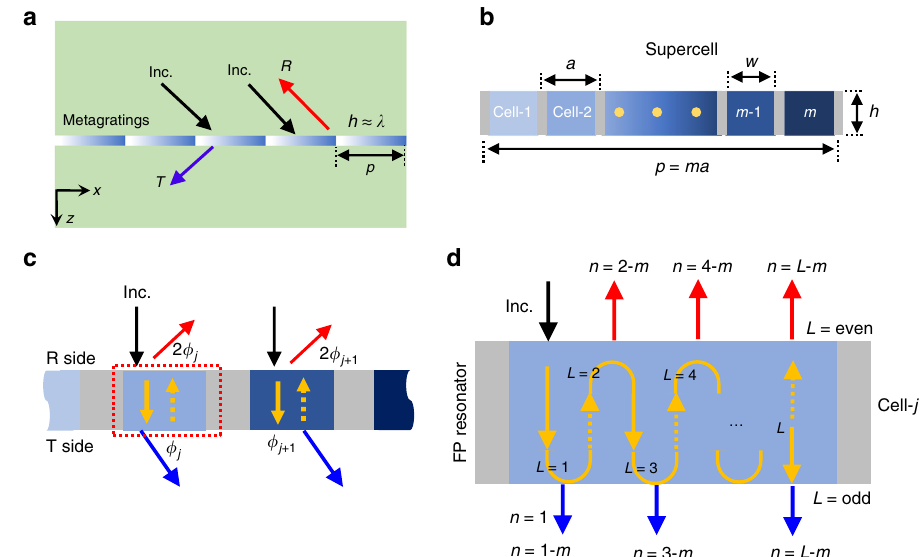
Fig. 1 Concept of studied metagratings. a Schematic diagram of the proposed PGM consisting of periodically repeated supercells. b Geometric topology of the supercell composed of m groups of unit cells. The regions in gray are sound-hard materials and the regions with blue colors are gradient index materials for generating gradient phase shift along + x- direction. c Trajectories of rays propagating in two adjacent unit cells. d Sketch map of diffraction mechanism and multiple re fl ections effect in the j th unit cell in ( c ). Each unit cell can be regarded as a Fabry – Perot (FP) resonator, inside which the wave oscillates back and forth L times before reaching a resonance condition that determines the re fl ection or transmission. The higher order diffraction depends on the propagation number L and the number m of unit cells in a